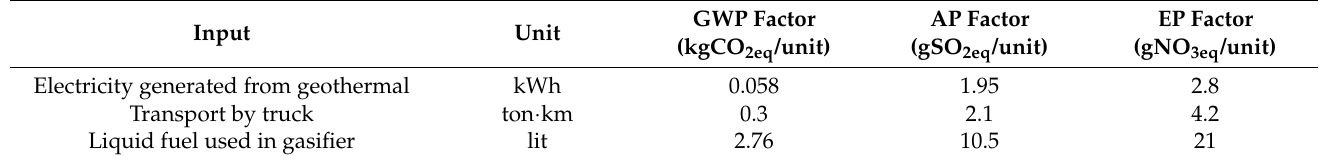
Table 3. GWP, AP, and EP factors for different inputs